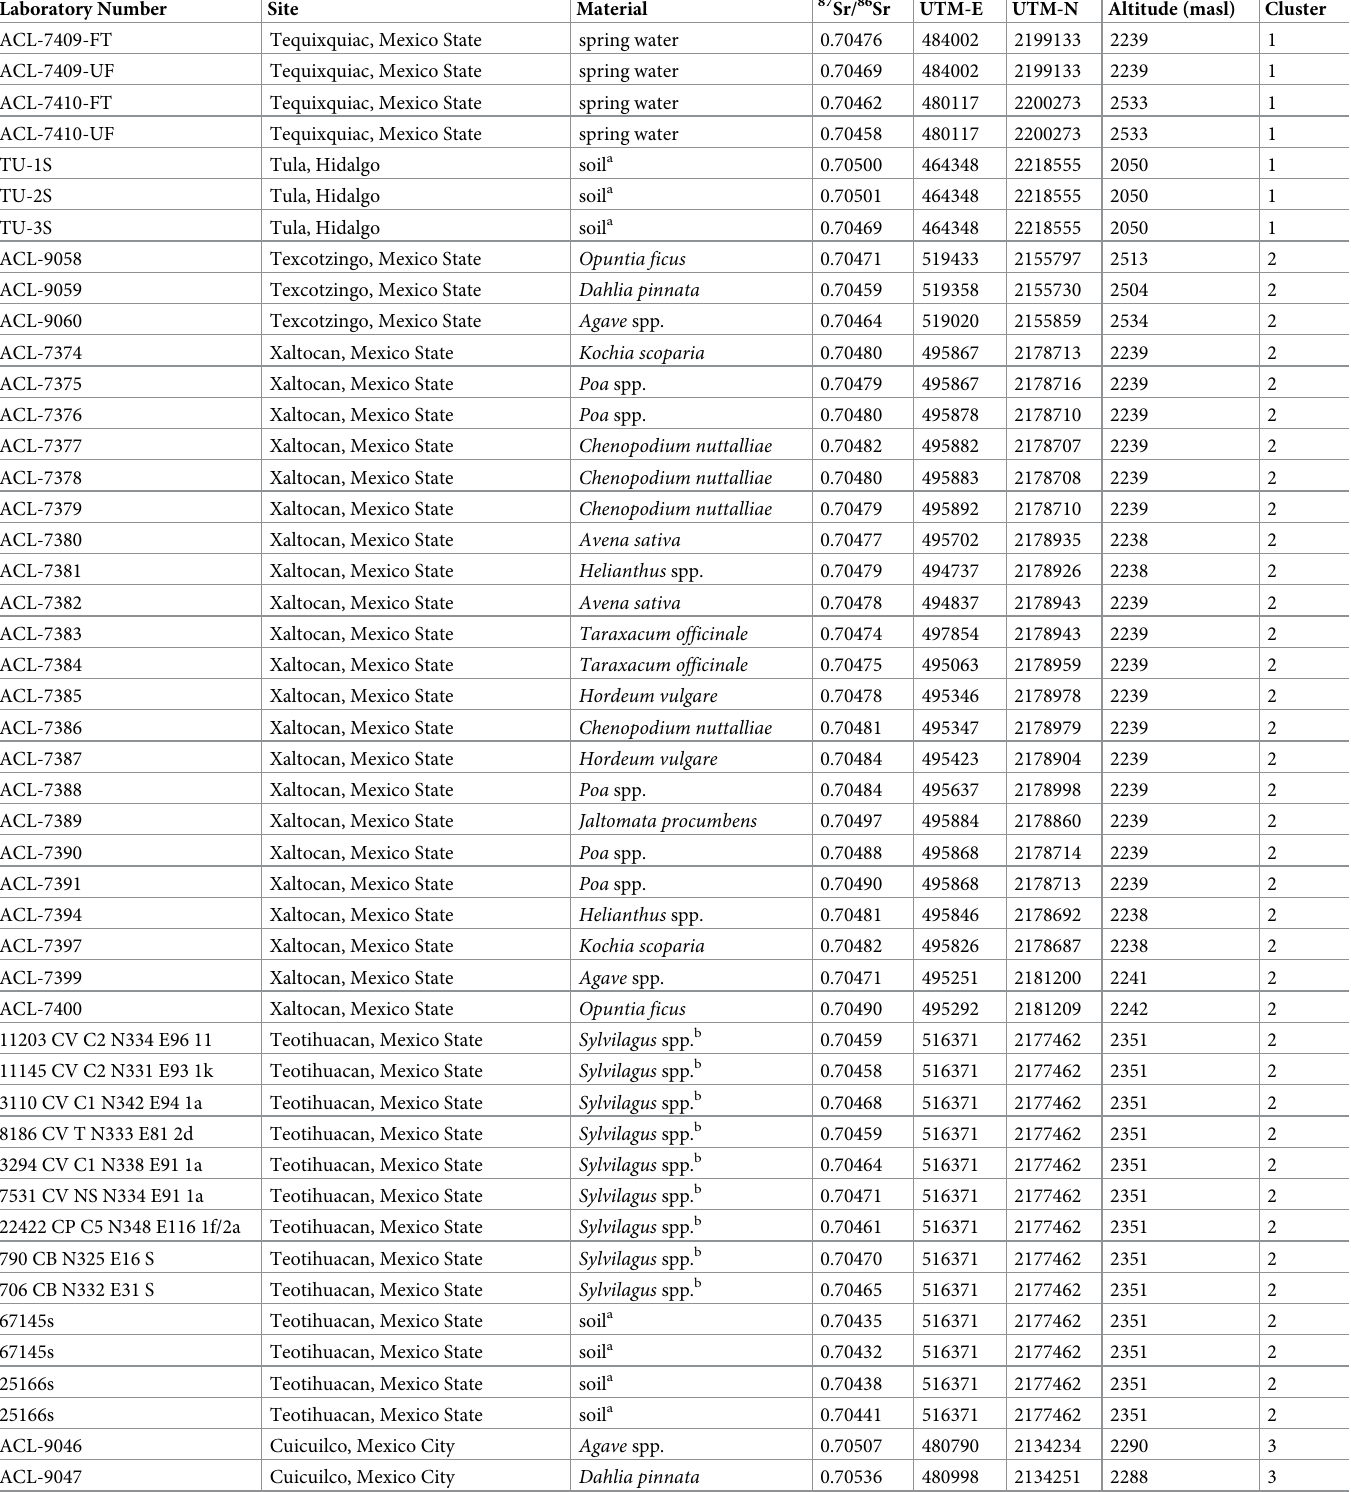
Table 1. 87 Sr/ 86 Sr and provenance data from Basin of Mexico and greater central Mexico baseline